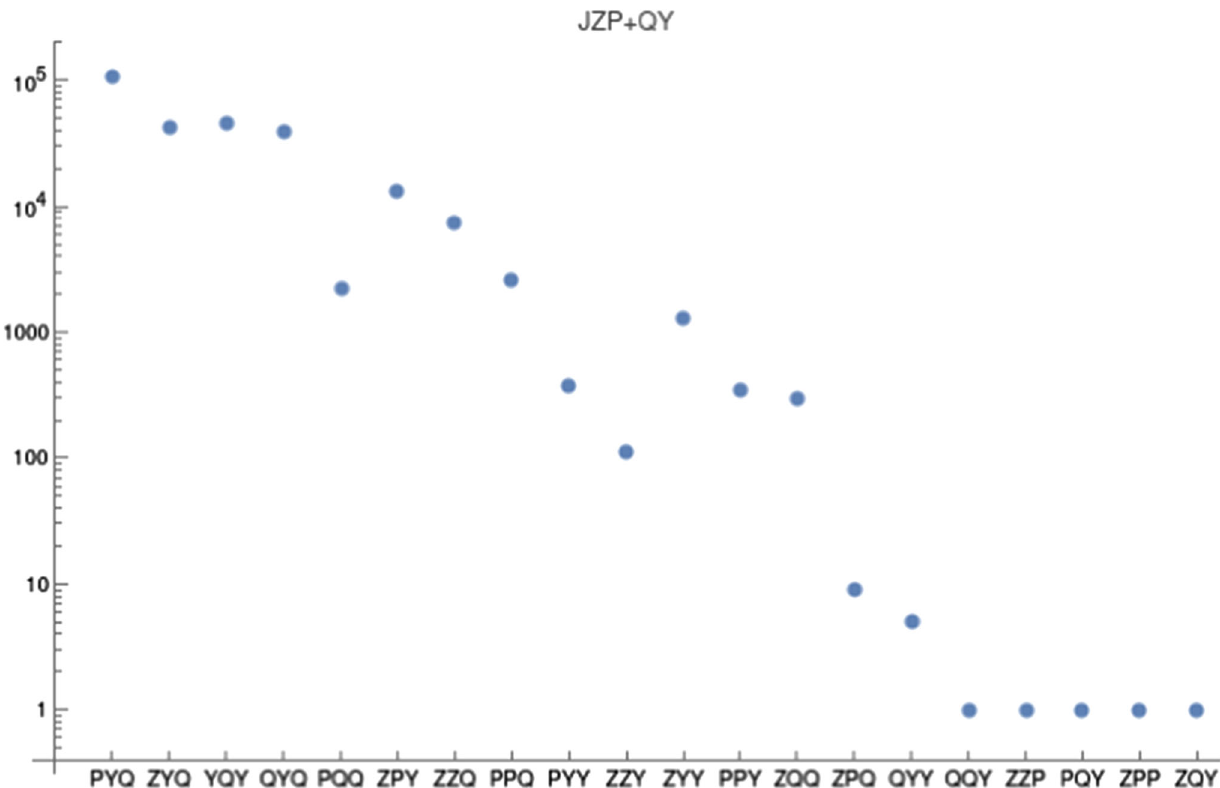
Fig. 1 The final distributions of the most ‘problematic’ Jacobi identities during the search process. “PQQ” refers to Jacobi ( P , Q , Q ) and so on